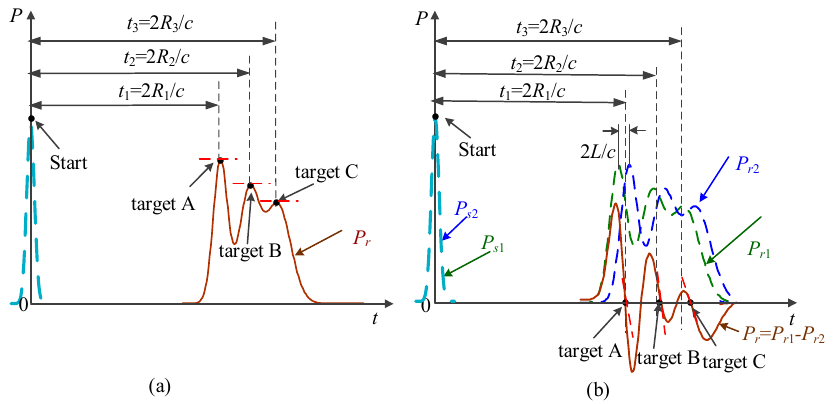
Figure 3. Echo signal comparison between peak and zero crossing. ( a ) Peak position by single time-resolved bucket detector. ( b ) Zero crossing by finite difference.